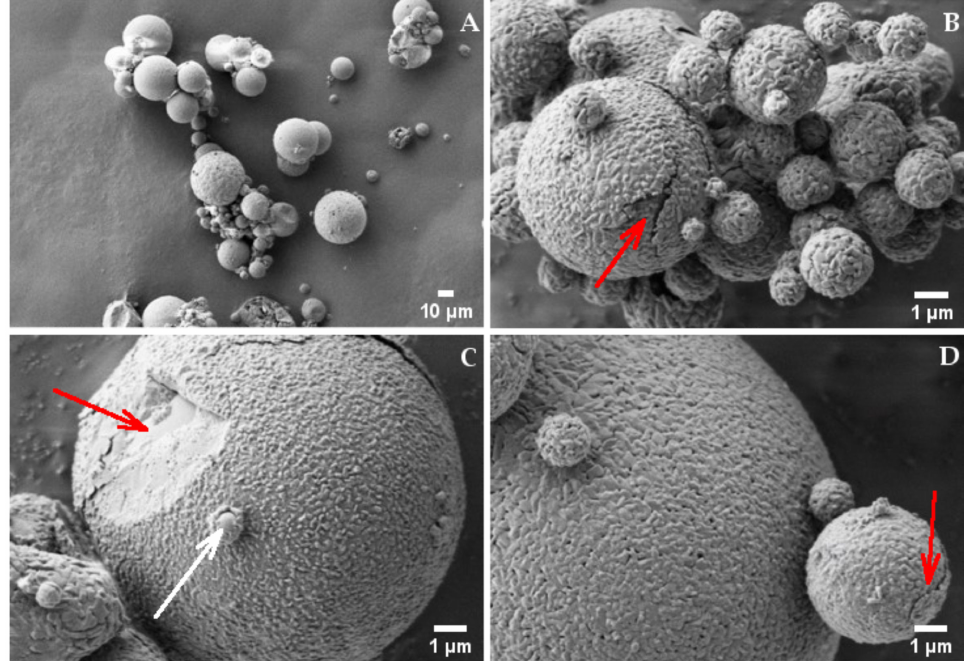
Figure 3. SEM picture of HYA–DEX microparticles taken at ( A ) 1000 × and ( B – D ) 20,000 × magnifi- cations. Red arrows: ( B , D ) particle cracks, ( C ) wrinkled surface. White arrow: small and smooth particles, partially surrounded by the wrinkled